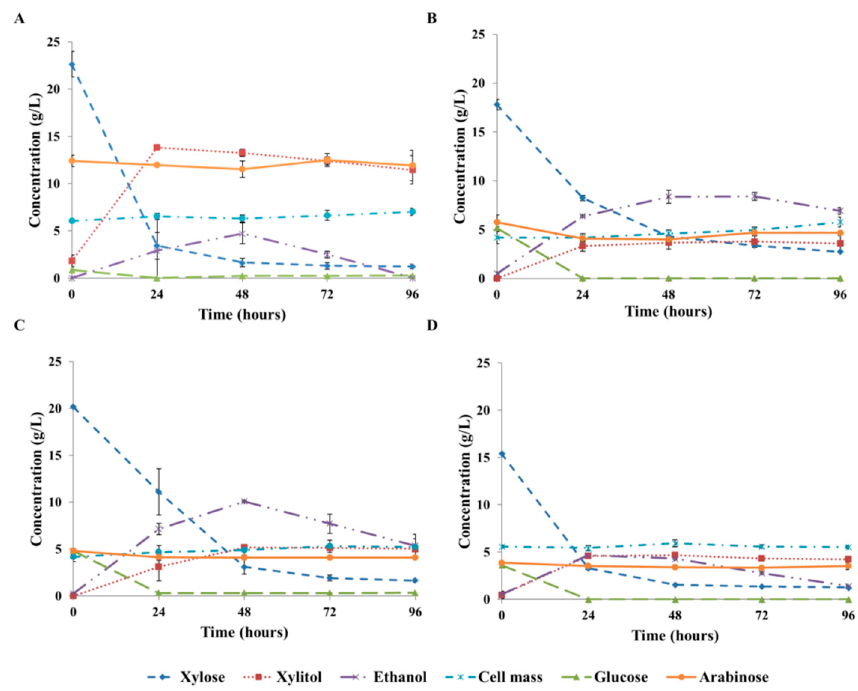
Figure 3. Profiles of the xylitol fermentations on WB1/S ( A ) GRS/S ( B ) GRS/S supplemented with 2 g/L peptone ( C ) and GRS/S treated by activated carbon and supplemented with 2 g/L peptone ( D ) using Candida boidinii NCAIM Y.01308. Standard deviations are calculated from